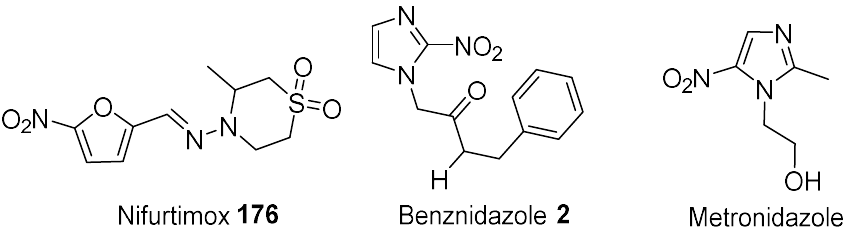
Figure 32. Chemical structure of Nifurtimox 176 , Benznidazole 2 , and Metronidazole 7.